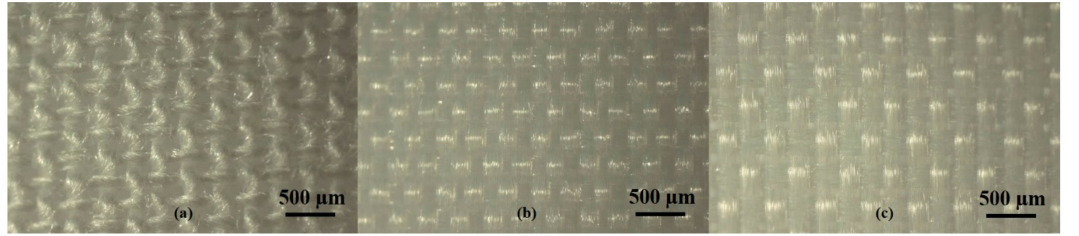
Figure 3. Optical images of ( a ) cotton, ( b ) nylon, and ( c ) polyester fabrics used to estimate the warp and weft thread counts in a 1 × 1 cm area.